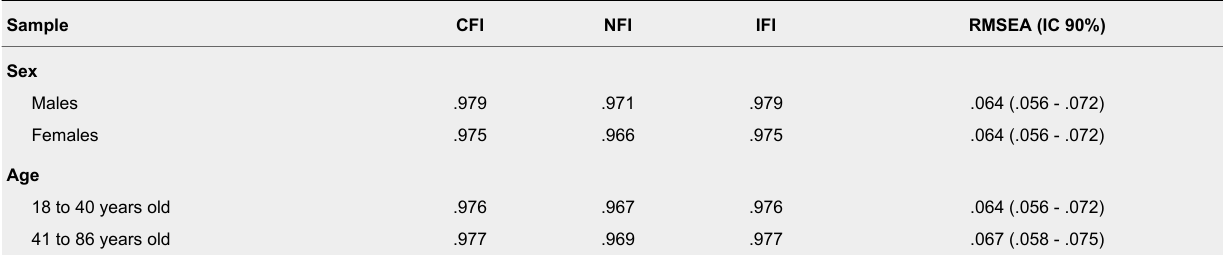
Cross-Validation: Model Fit by Sex and Age.